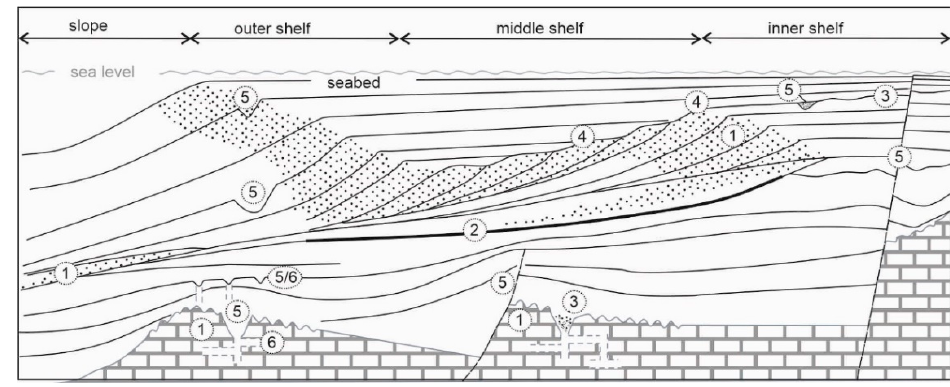
Figure 17. Schematic cross geological section across part of a passive continental margin, showing the stratigraphic and morpho-structural elements detectable through seismic interpretation, which support the identification and mapping of low salinity aquifers. 1-Reservoir (aquifer), 2-Seal (aquitard/aquiclude), 3-Paleo-continental environments, 4-Paleo-coastline, 5-Conduits (e.g., canyons, valleys, channels, sinkholes, faults) 6-Aquifer indicators. See text for detailed explanation of each of these elements. Sequence stratigraphic framework modified from Reference [155].